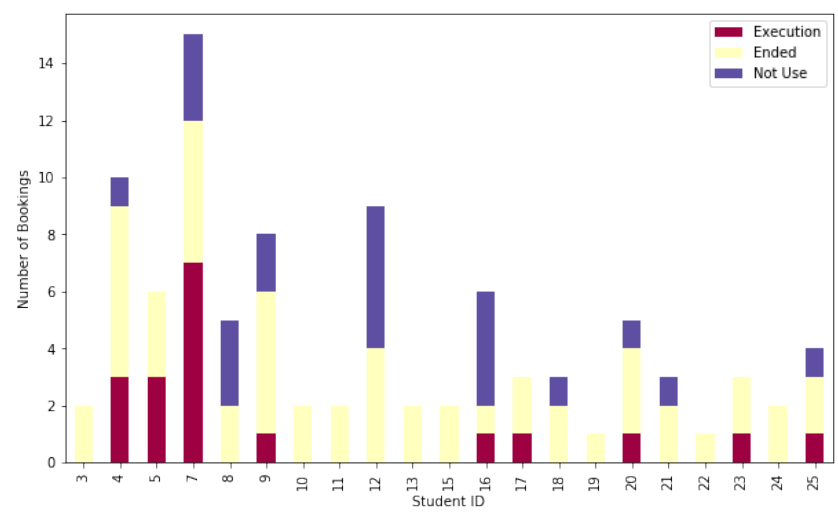
Figure 8. Amount of Booking Sessions per Student (Divided by Status).